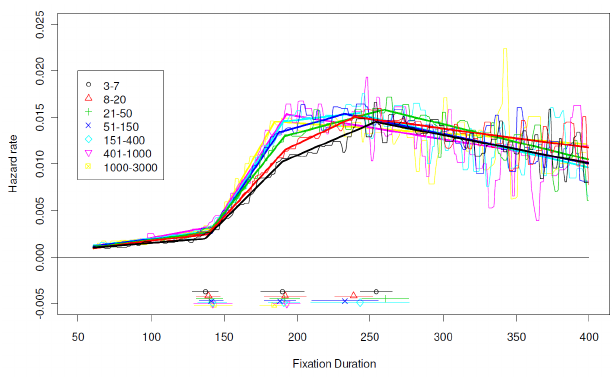
Figure 6. Effects of Word Frequency on Hazard Function of Fixation Duration (Dundee corpus)